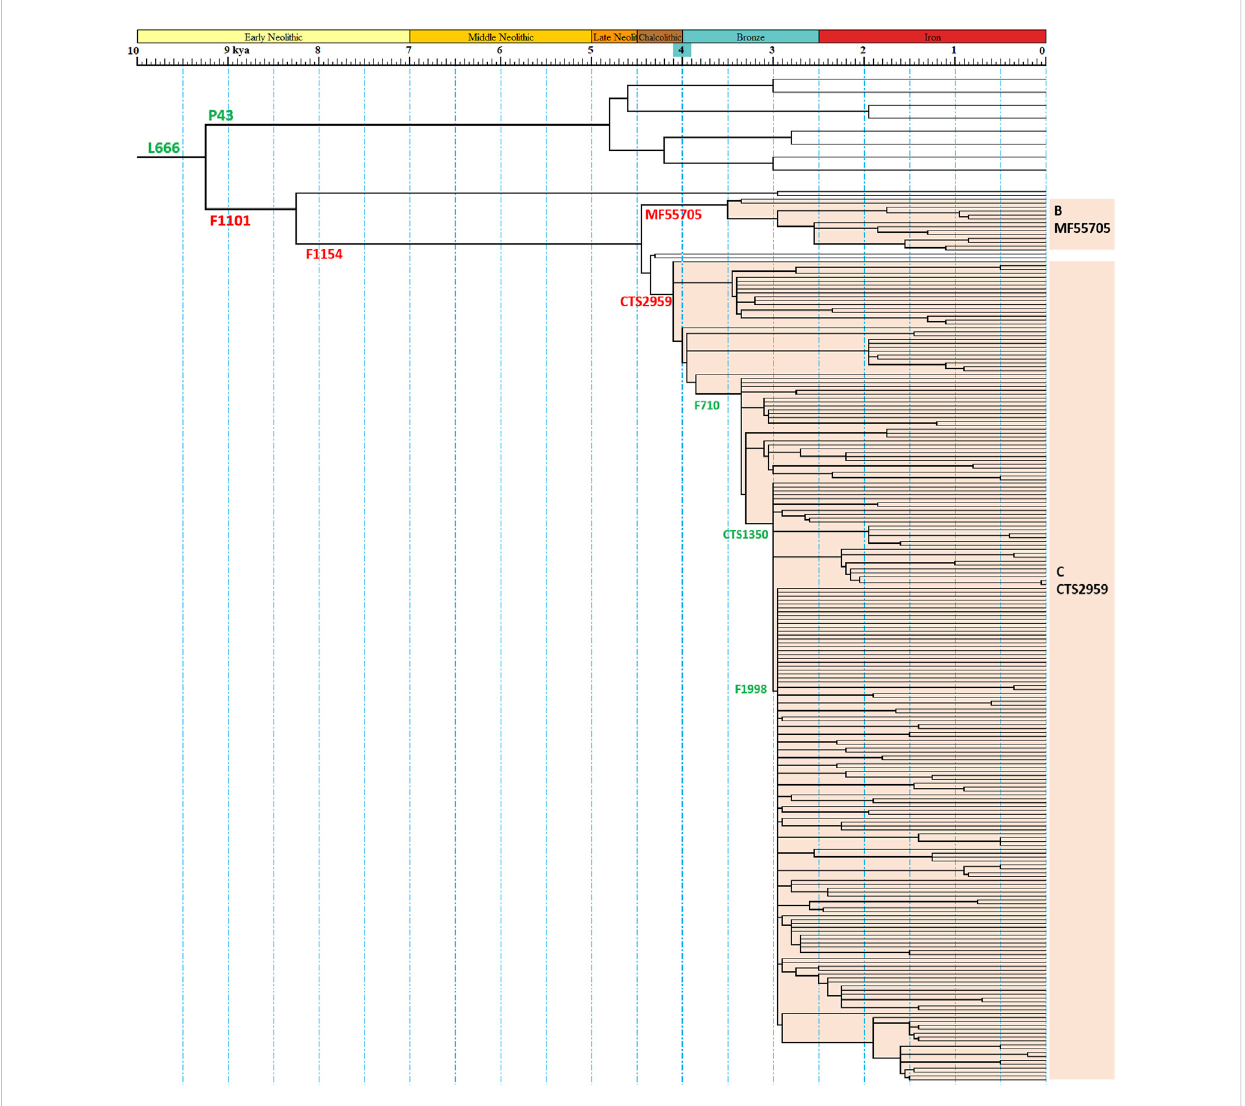
FIGURE 1 Schematic diagram of the revised phylogeny of haplogroup N1a2a-F1101. The red SNP labels indicated the de fi nition marker of categories of sub- branches in this study. The green SNP labels indicated other important marker of the phylogenetic